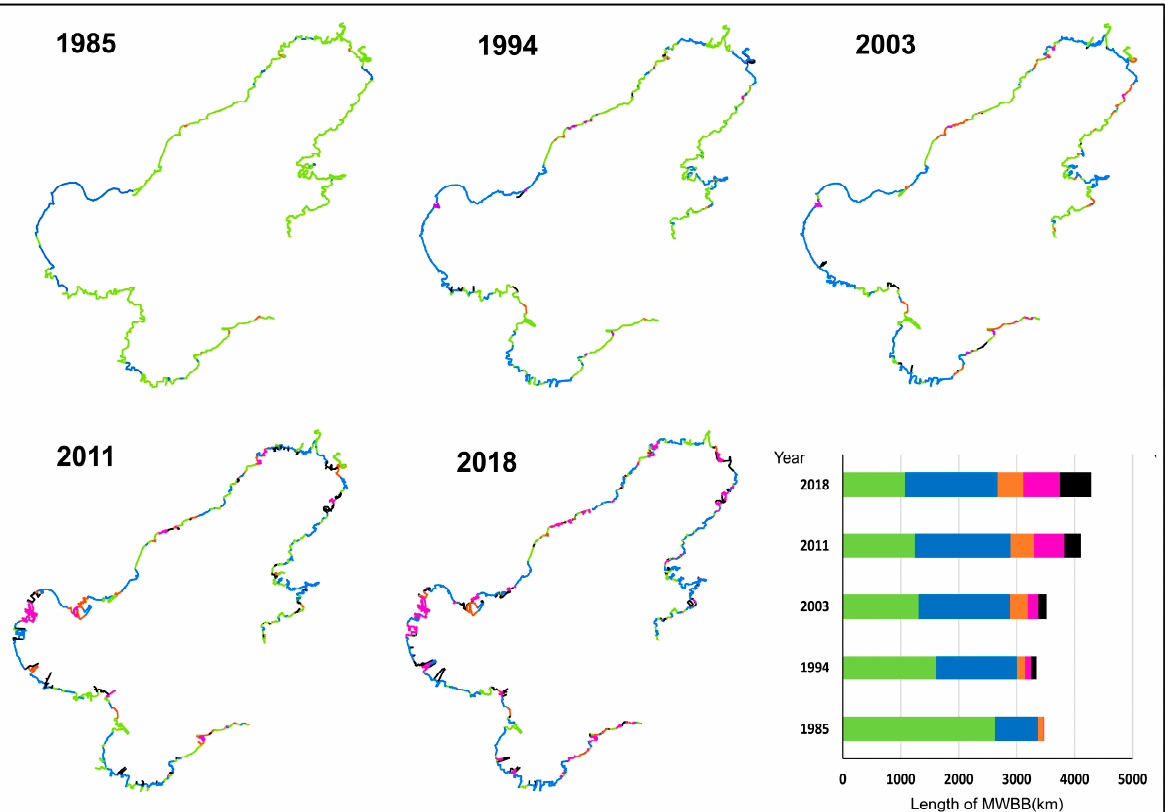
Figure 7. Spatio-temporal changes of the boundary types of the Bohai Sea in Phase 5. Green, blue, orange, red, and black denote the natural boundary, pond dam, industrial and urban area, marine construction, and protective dam, respectively.